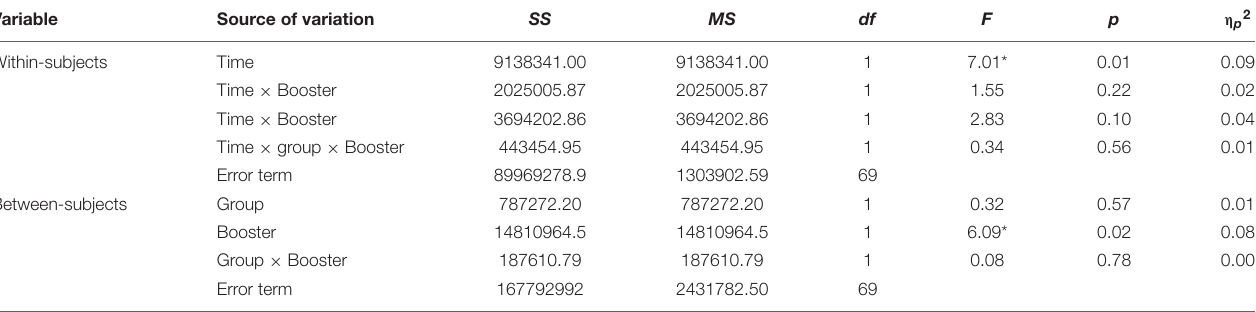
TABLE 6 | Repeated-measures ANOVA of exercise for different types and periods of mental